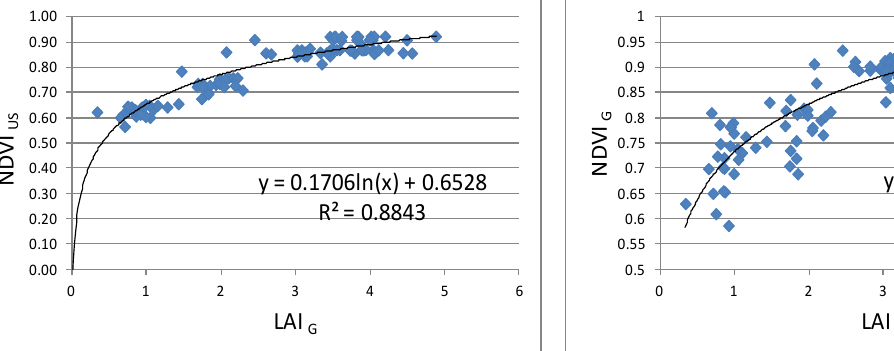
y = 0.1706ln(x) + 0.6528 R² = 0.8843